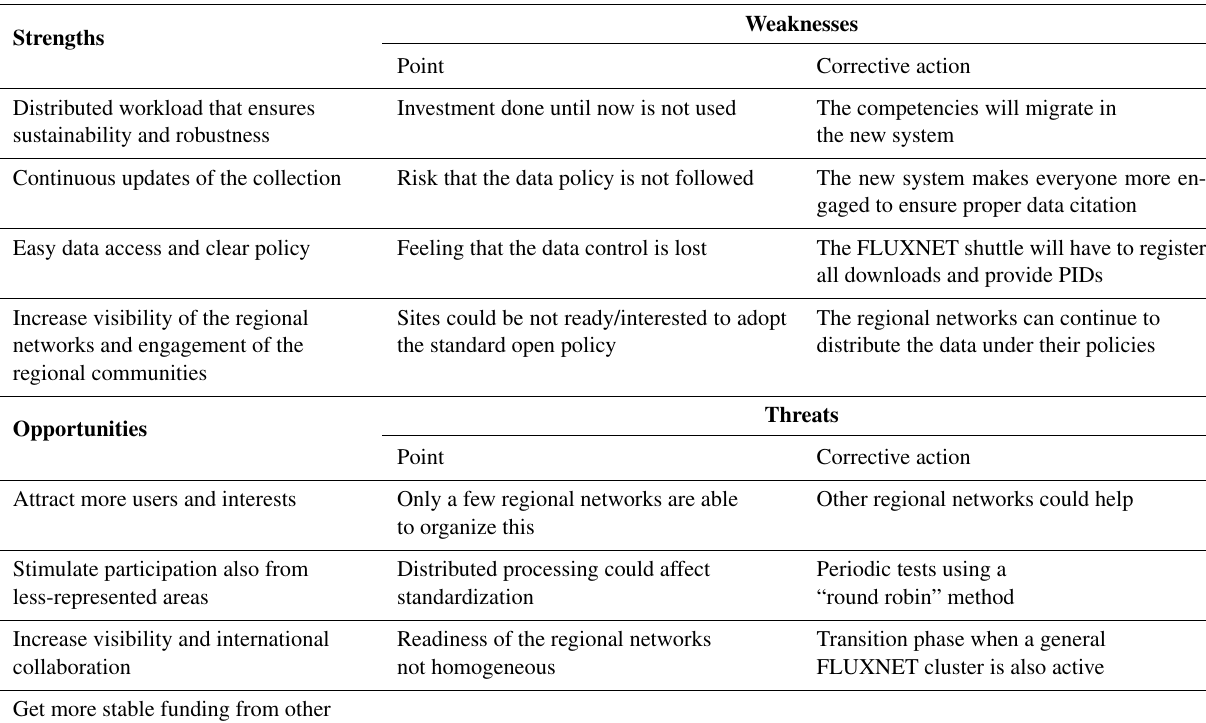
Table 2. SWOT (Strengths, Weaknesses, Opportunities, Threats) analysis of the new proposed system. For the weaknesses and threats, possible corrective actions are also